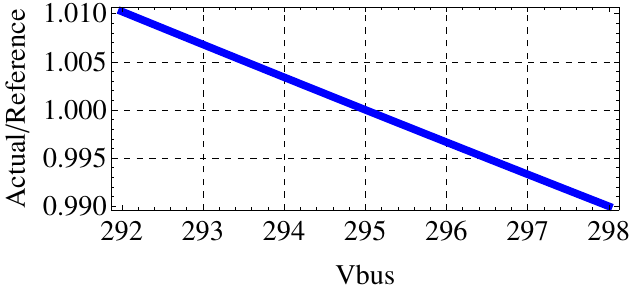
Figure 25. Ratio of actual to ideal reference current with respect to measured bus